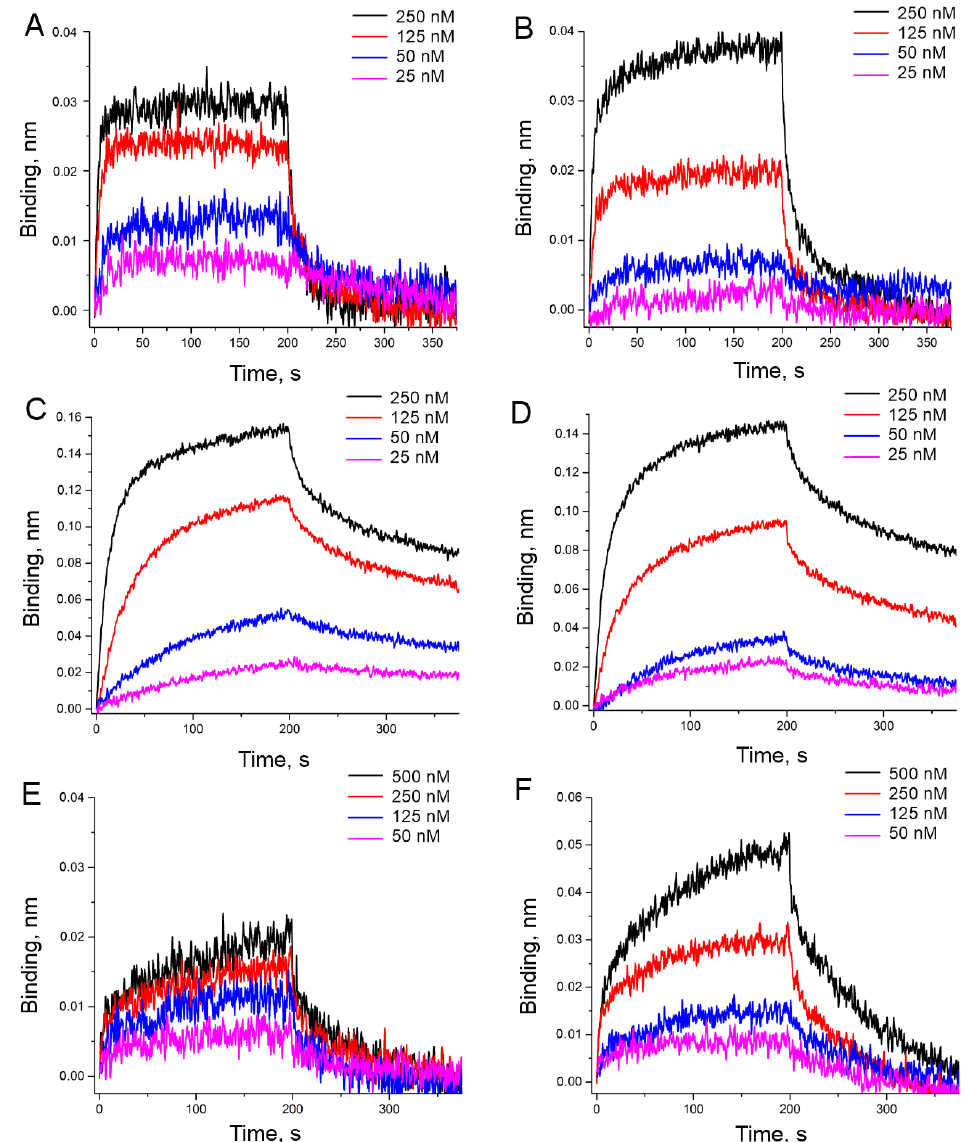
Figure 4. Binding of the aptamers to thrombin: ( A , B ) HD1; ( C , D ) carboxy-T4,T13-HD1; ( E , F ) biotinylated-T4,T13-HD1. The aptamer assembly and the binding experiments were carried out in ‘potassium buffer’ with 10 mM K + and 140 mM Na + ( A , C , E ) or in ‘sodium buffer’ with 140 mM Na + ( B , D , F ). The association stage was 200 s long; the dissociation stage was 300 s long.